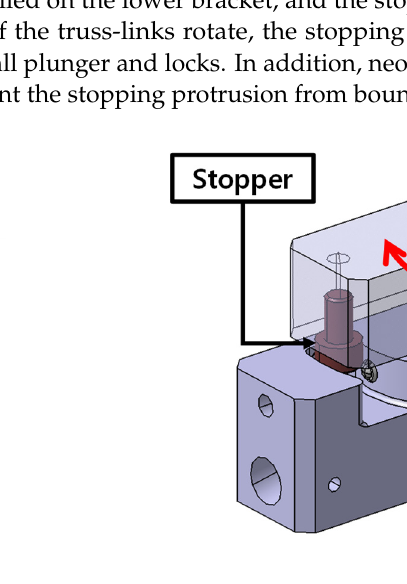
Figure 5. Configuration of latching mechanism: ( a ) Neodymium magnet, ball plungers ( b ) Latching system.